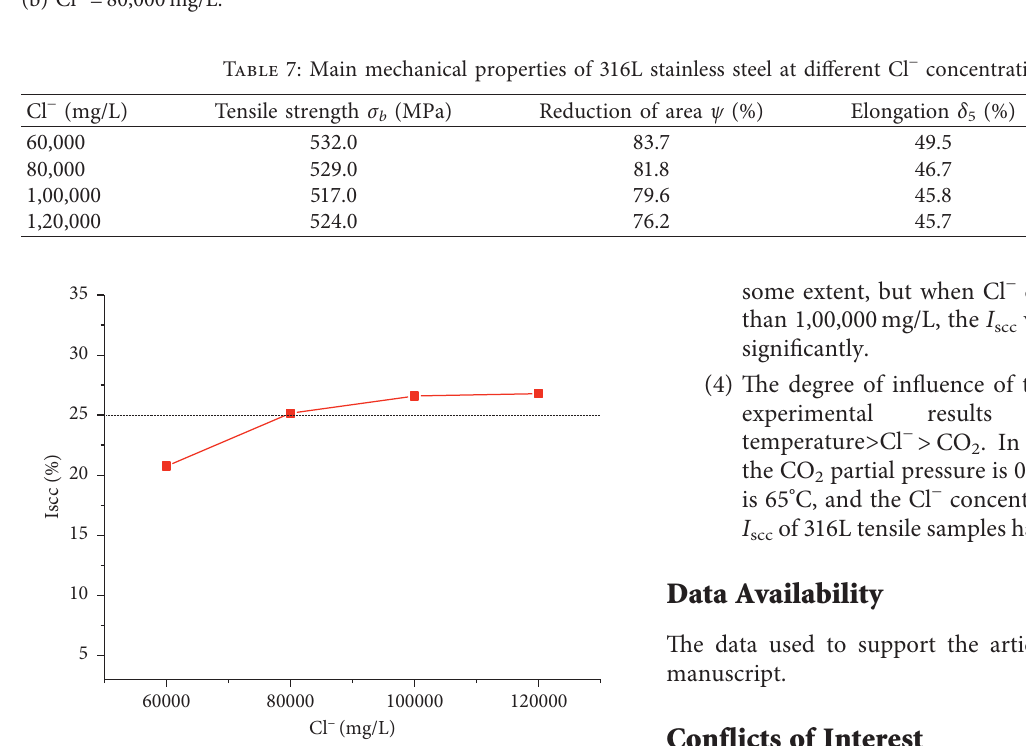
� 0.1Mpa, T � 65 ° C): (a) Cl − � 60,000mg/L; 2